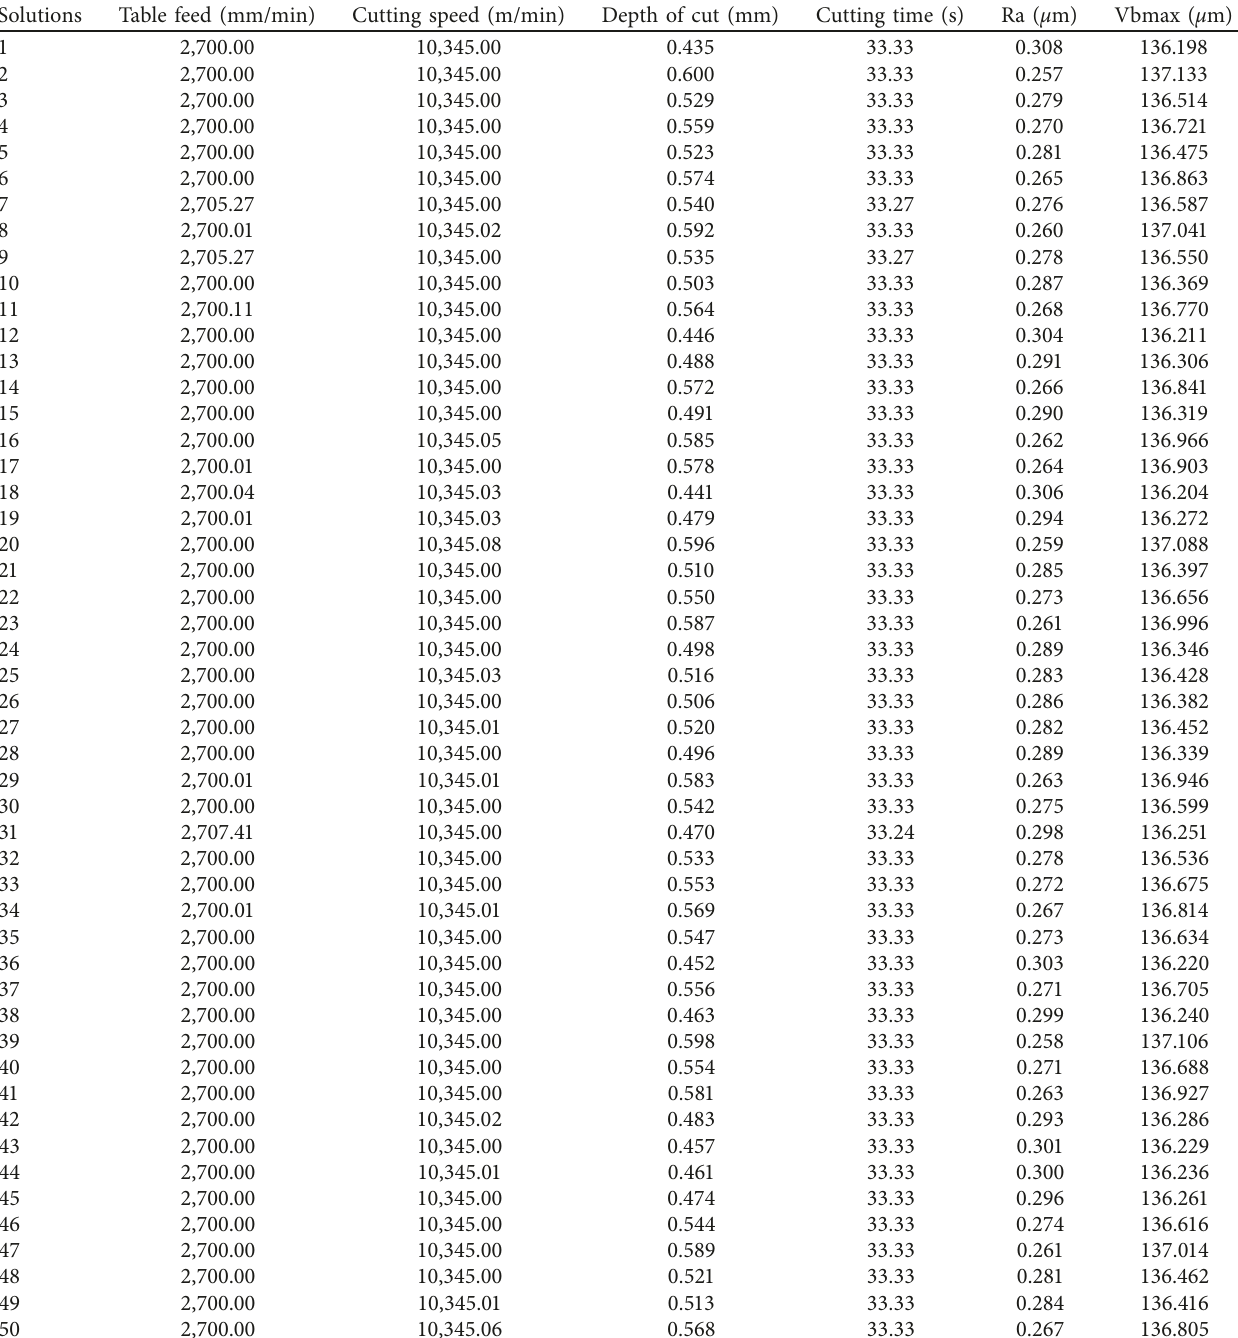
Table 10: Performance statistics obtained by 50 Pareto solutions.